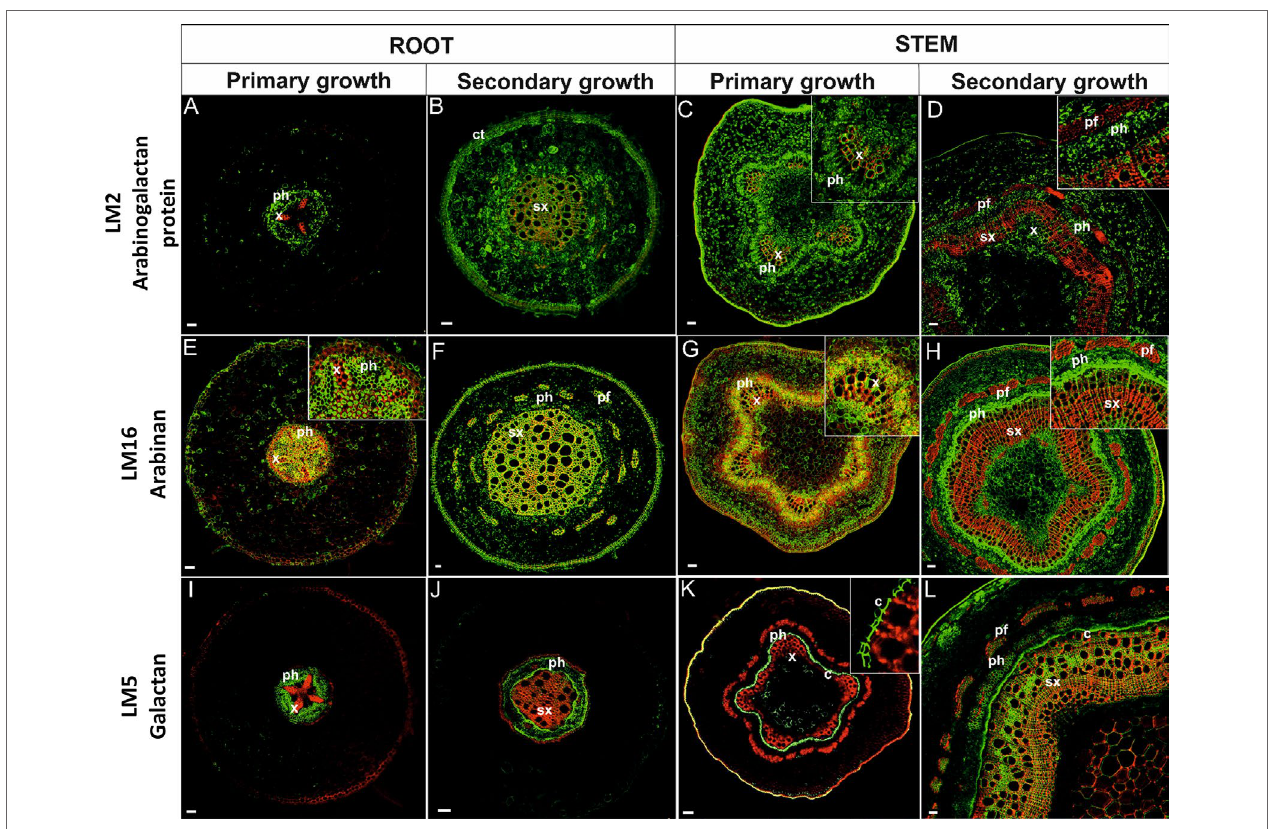
FIGURe 6 | Immunolocalization of arabinogalactan proteins (a – D) , arabinan (e – h) , galactan (I – l) and their co-localization with ligninsin in pioneer roots and stem during different developmental stages. [x, primary xylem; ph, phloem; sx, secondary xylem; pf, phloem fibers; c, cambium; ct, cork tissue (phellem)]. Bars 50 µm.